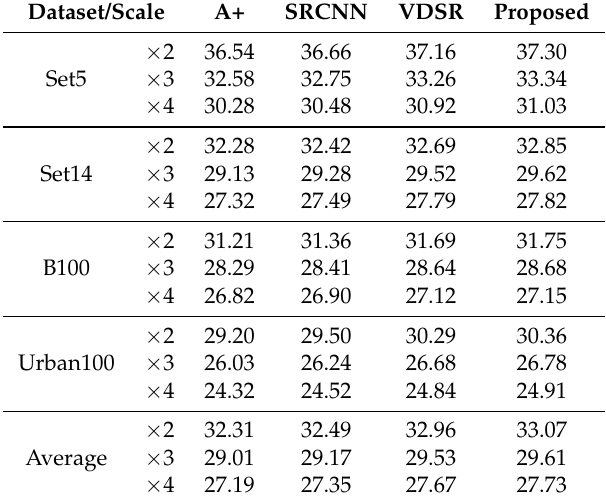
Table 1. Comparison of peak signal-to-noise ratio (PSNR) among the proposed method, A+ [11], SRCNN [1], and VDSR [2]. (The results of A+ and SRCNN are taken from [2].) For the proposed method, k = 5, n = 4, and λ i = 2.5 (initial).